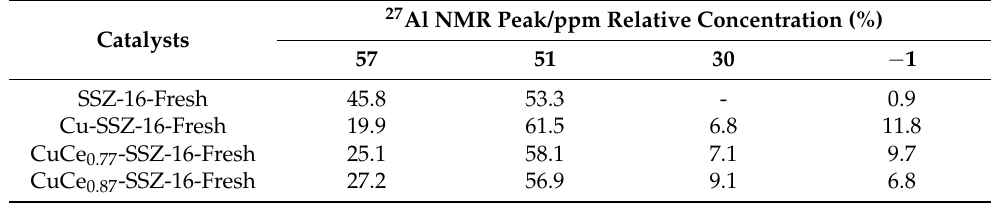
Figure 7. ( a ) Deconvolution of the NH 3 -TPD curves and ( b ) the corresponding areas over Cu-SSZ- 16-Fresh, CuCe 0.77 -SSZ-16-Fresh, and CuCe 0.87 -SSZ-16-Fresh. 2.3. Cu and Ce Species XPS was performed to inquire about the chemical state of the two species introduced, and the XPS results of the fresh samples are exhibited in Figure 8. The Cu 2p spectrum (Figure 8a) is divided into two peaks at around 933.1 and 935.9 eV, which may correspond to the presence of Cu + and Cu 2+ species [28,33,38,39]. The integral area fraction results of Cu-SSZ-16-Fresh, CuCe 0.77 -SSZ-16-Fresh, and CuCe 0.87 -SSZ-16-Fresh are depicted in Table 3. The relative amount of Cu 2+ signi fi cantly increases from 32.8% to 40.4% and then to